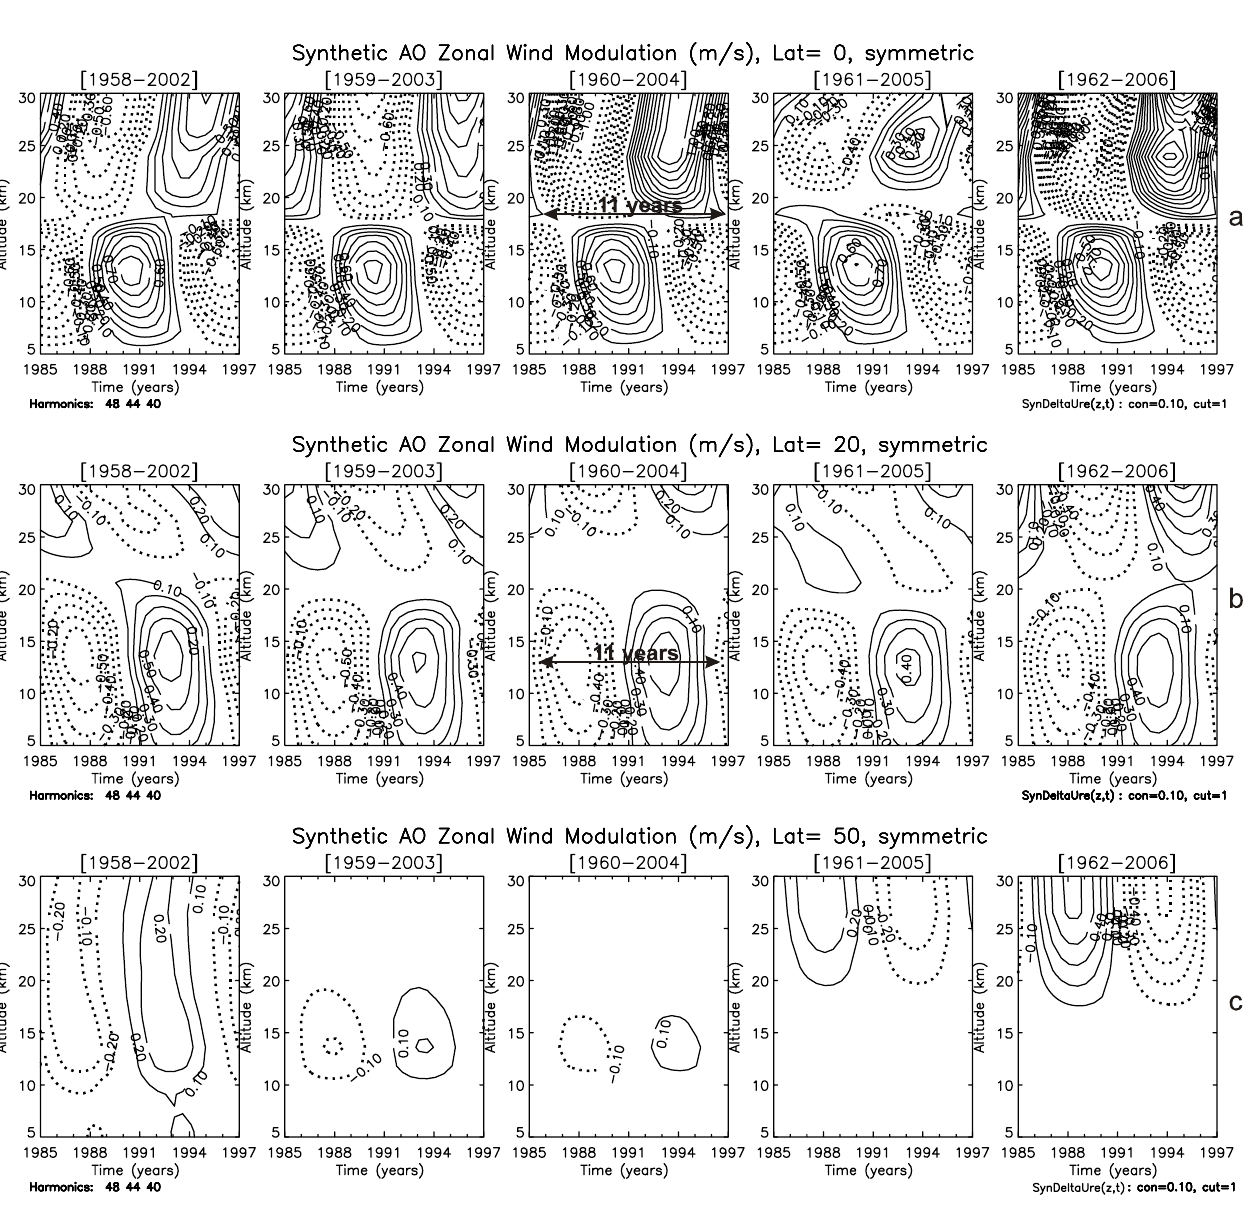
Fig. 3. Synthesized zonal wind modulations of the symmetric AO for the moving 44-year time intervals beginning in 1958 and ending in 2002 at the equator (a) , and at 20 ◦ (b) and 50 ◦ (c) latitudes. The harmonics h=44 and 44 ± 4 are synthesized, like in Fig. 2b. Since the oscillation patterns repeat in 11-year intervals, the results are shown only for the years from 1985 to 1997. At the equator (a), the 11-year modulation peaks between 10 and 15km, and the maximum occurs near 1990 in each of the windows, which indicates that the variations are phase locked due to potential forcing by the SC. The modulation pattern at higher altitudes, however, varies in amplitude and phase, indicative of a less systematic source. At 20 ◦ latitude (b), and below 20km, systematic 11-year zonal wind modulations are generated with smaller amplitudes; and at mid latitudes (c), the modulations all but